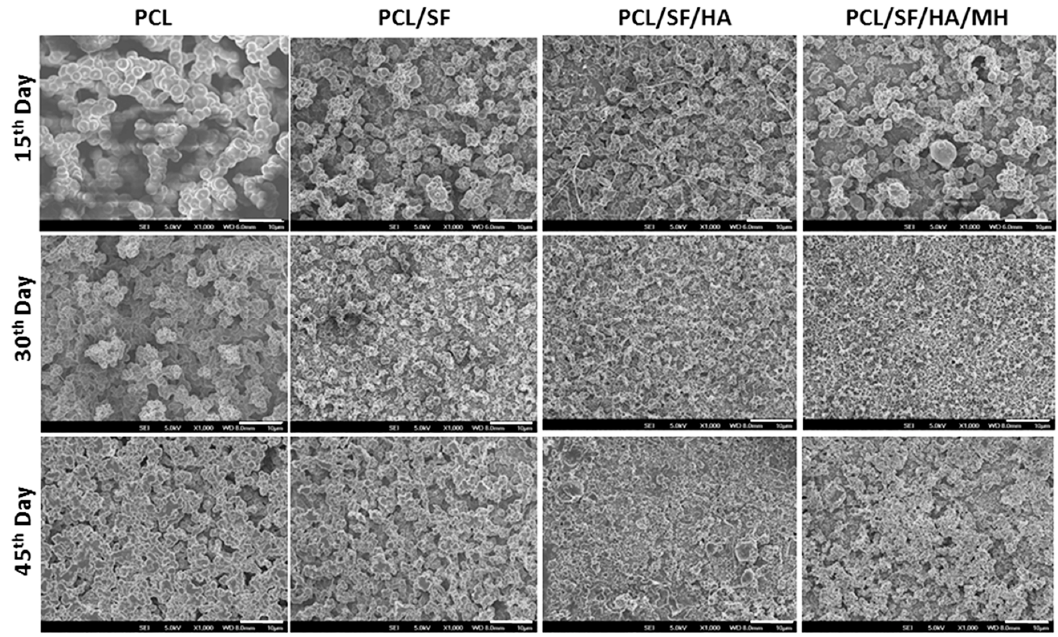
Figure 4. FESEM images show the degradation studies of biocomposite particles at various time points (Scale bar: 10 µm).